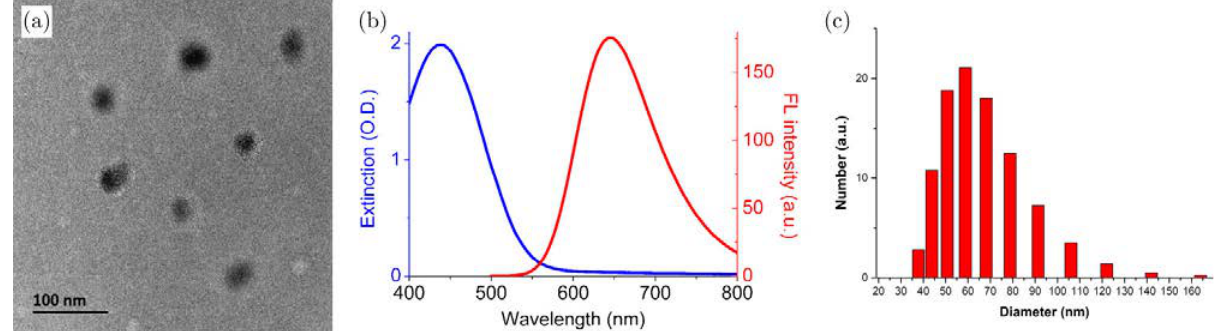
Fig. 3. (a) TEM image of DCDPP-2TPA NPs. Scale bar: 100 nm. (b) Extinction spectrum (blue) and °uorescence spectrum (red) of DCDPP-2TPA NPs in aqueous dispersion; 0.05mg mL (cid:3) 1 of DCDPP-2TPA. Excitation wavelength = 450 nm. (c) Dynamic light scattering data of DCDPP-2TPA